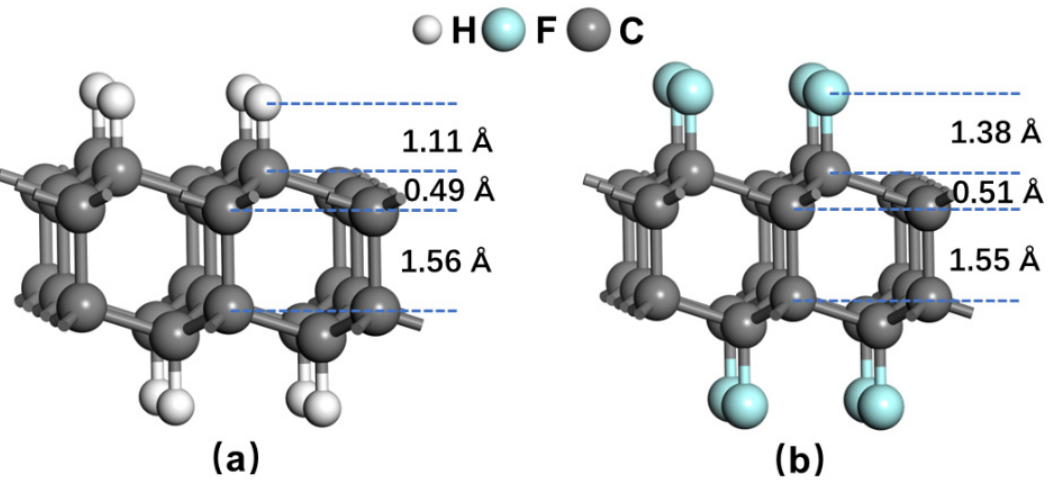
Figure 1. The optimized geometry structures of ( a ) H-diamane and ( b ) F-diamane. Based on the optimized structures, two sheets of H-diamane (H-diam/H-diam) or F-diamane (F-diam/F-diam) were placed to slide against each other along a path to model the friction process, as shown in Figure 2. As the upper layer of diamane slides across the lower one along the diagonal of two primitive lattice vectors (the red dotted arrow in Figure 2b), the highly symmetric top (Figure 2b), hollow (Figure 2c), and bridge (Figure 2d) stackings will alternately appear on the path. According to our previous studies [30,46– 48], the friction properties of the hexagonal system are decided by these three stacks.